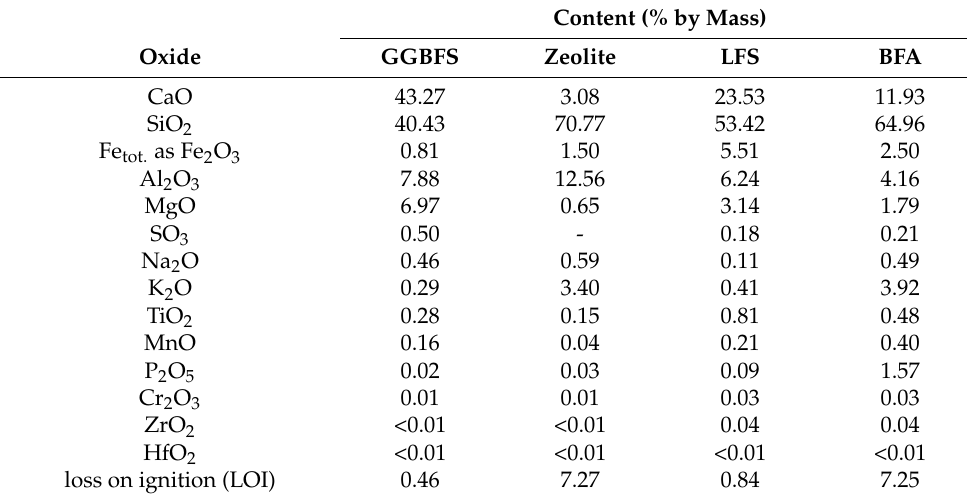
Table 3. The chemical composition of GGBFS, furnace slag (LFS), fly ash from the biomass block (BFA) and zeolite used in the examination